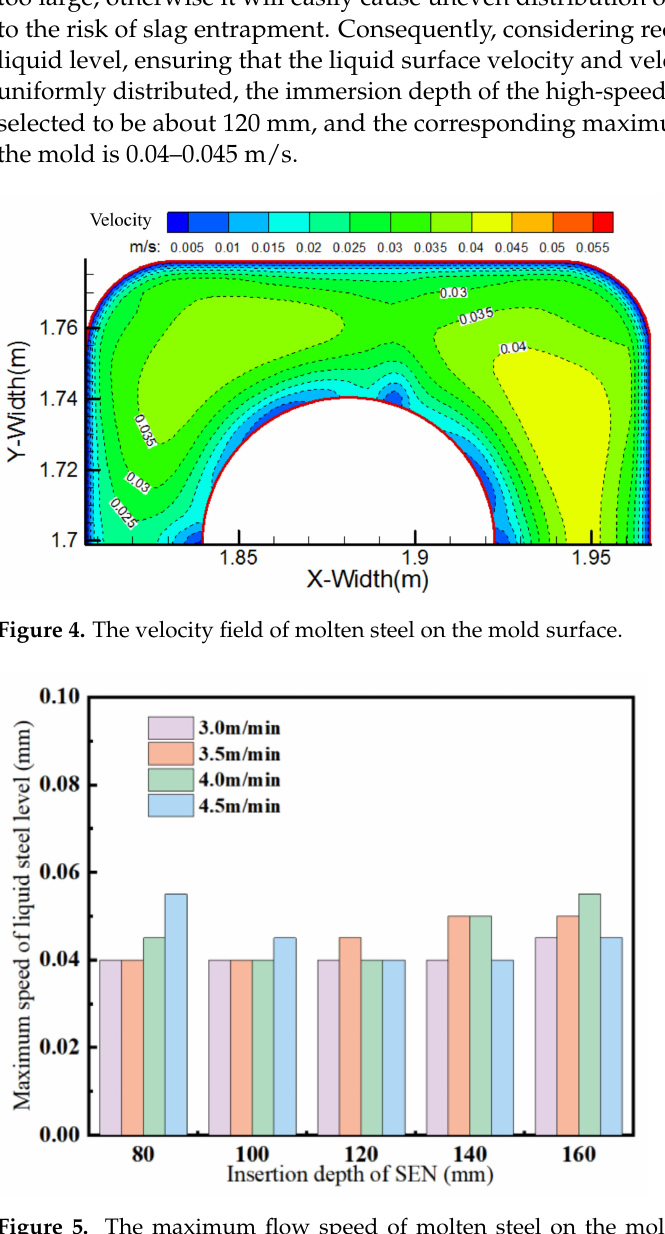
Figure 5. The maximum flow speed of molten steel on the mold surface under different SEN immersion